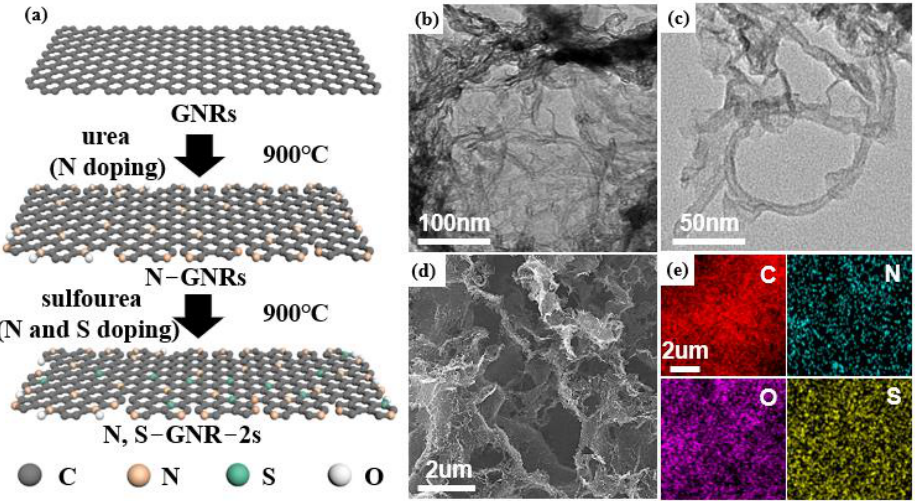
Figure 1. ( a ) The synthesis process of N, S-GNR-2s. ( b , c ) TEM images of N, S-GNR-2s. ( d ) The SEM image and ( e ) the corresponding EDS element mappings of N, S-GNR-2s showing the distribution of C, N, O and S.